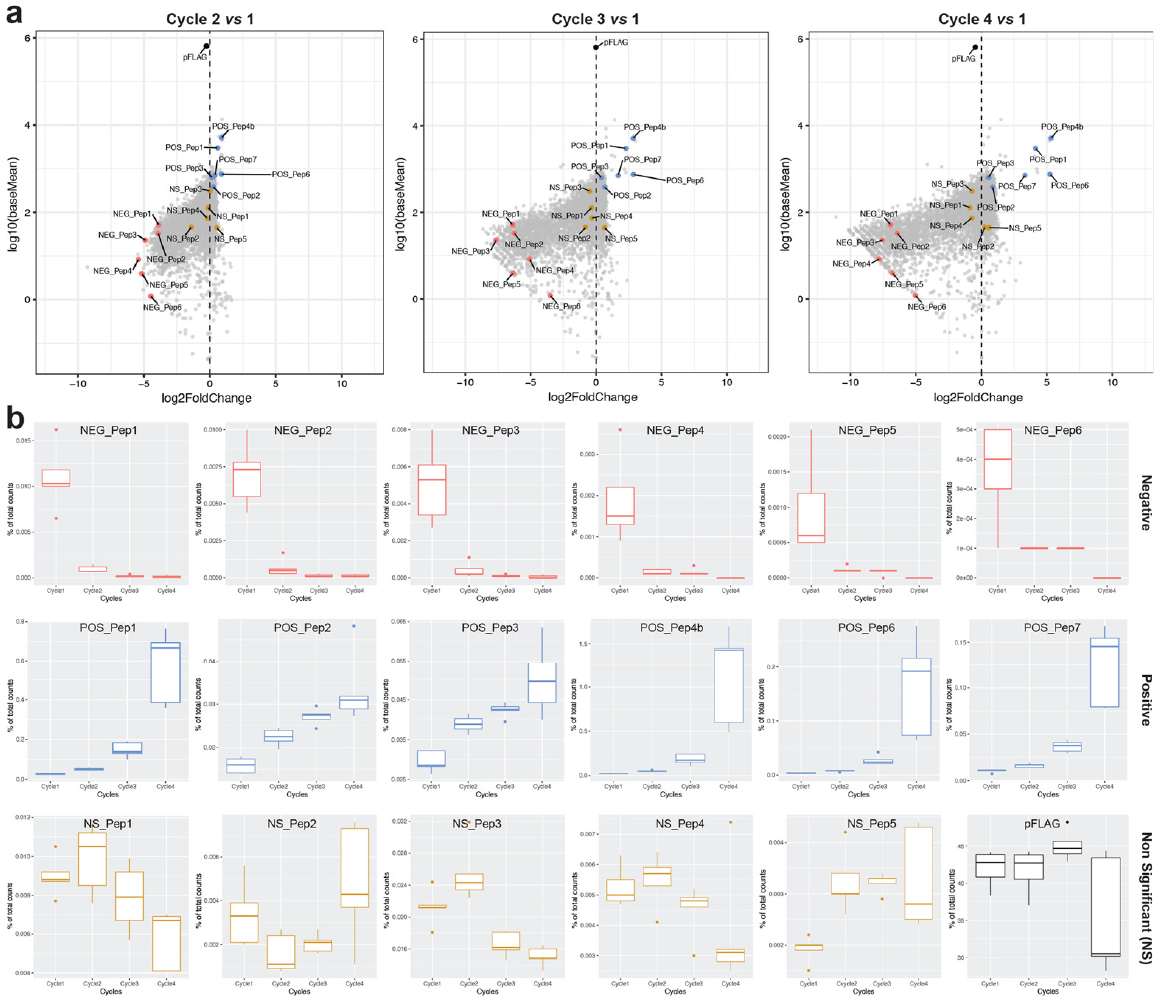
Figure 1. Performance characteristics of the candidate clones in the bulk experiment. Data are based on the deep sequencing experiment described in [14]. ( a ) Frequency changes of candidate clones during the growth cycles of the random sequence library in the background of all analyzed clones. Plots are based on the statistical analysis of clone frequency changes with DESeq2 [18], comparing mean counts of clones in the starting library (cycle 1) versus fold-changes at cycles 2, 3 and 4 (4 serial passages) for the deep sequencing experiment in [14] and its reanalysis in [18]. The y -axis shows the average read counts across the replicates (log10 (baseMean)); the x -axis is the relative change in clone frequency (log2FoldChange) at each cycle versus the counts at cycle 1. Candidates that are the focus of this study are highlighted with colored dots. We categorise the candidates into three clas- ses—NEG_Pep = negative (decreased in frequency—padj < 0.05 and negative log2FoldChange value), NS_Pep = neutral (no significant change in frequency—padj > 0.05), POS_Pep = positive (in- creased frequency—padj < 0.05 and positive log2FoldChange values), and pFLAG = empty plasmid (black dot). Note that the overall effect of the empty plasmid in this experiment is within the range of the effects of the neutral peptides, but this can vary somewhat between experiments [18]. ( b ) Individual frequency trajectories of the candidate clones during the four cycles of growth. Boxplots show medians with lower and upper hinges corresponding to the 1st and 3rd quartiles.